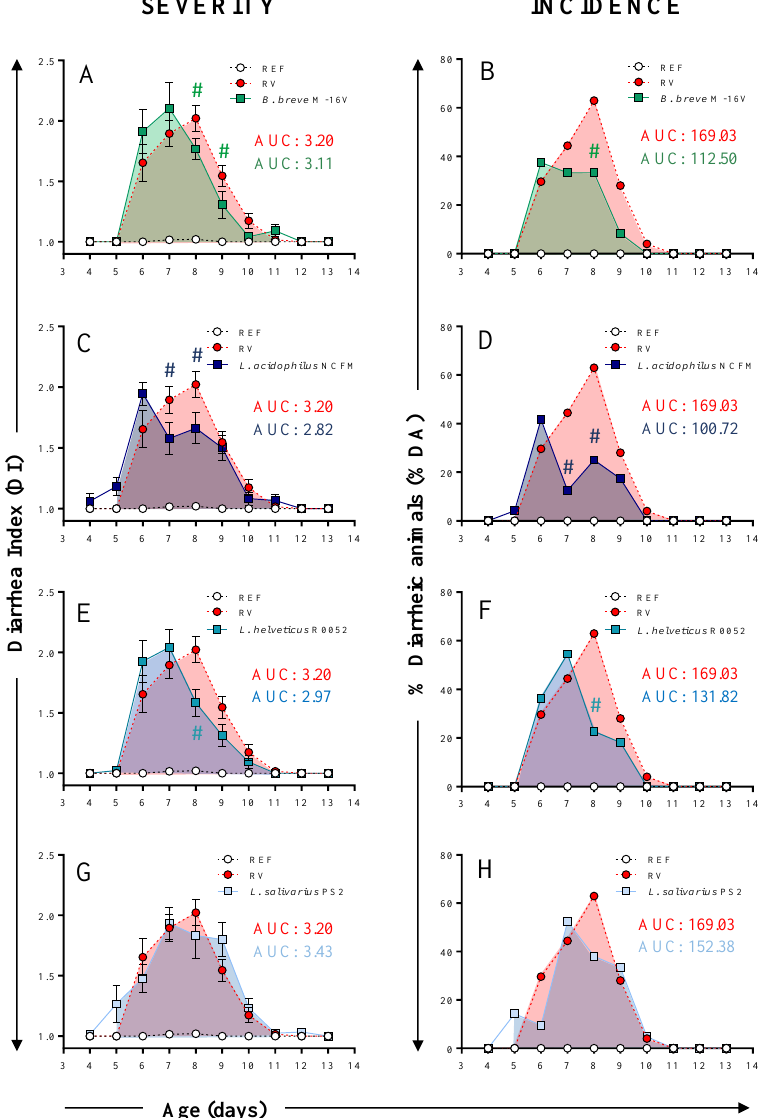
Figure 2. Clinical indices of diarrhea. Severity and incidence of diarrhea in animals receiving ( A , B ) B. breve M-16, ( C , D ) L. acidophilus NCFM, ( E , F ) L. helveticus R0052, and ( G , H ) L. salivarius PS2. The severity is expressed with the diarrhea index (DI) on a scale of 1 to 4. Scores of DI ≥ 2 indicate presence of diarrhea. The incidence of diarrhea is represented as the percentage of diarrheic animals (%DA), which corresponds to the percentage of animals displaying DI scores ≥ 2 in each group. The mean area under the curve (AUC) of severity and incidence, S-AUC and I-AUC, respectively, is represented with a colored shadow and its value is displayed in the right side of the graph. Results are expressed as mean ± S.E.M. ( n = 4–21 / group, depending on fecal sample availability). # p < 0.05 compared to the rotavirus (RV) group. REF: reference; B .: Bifidobacterium ; L .: Lactobacillus . Table 2. Variables describing severity, incidence and duration of diarrhea.